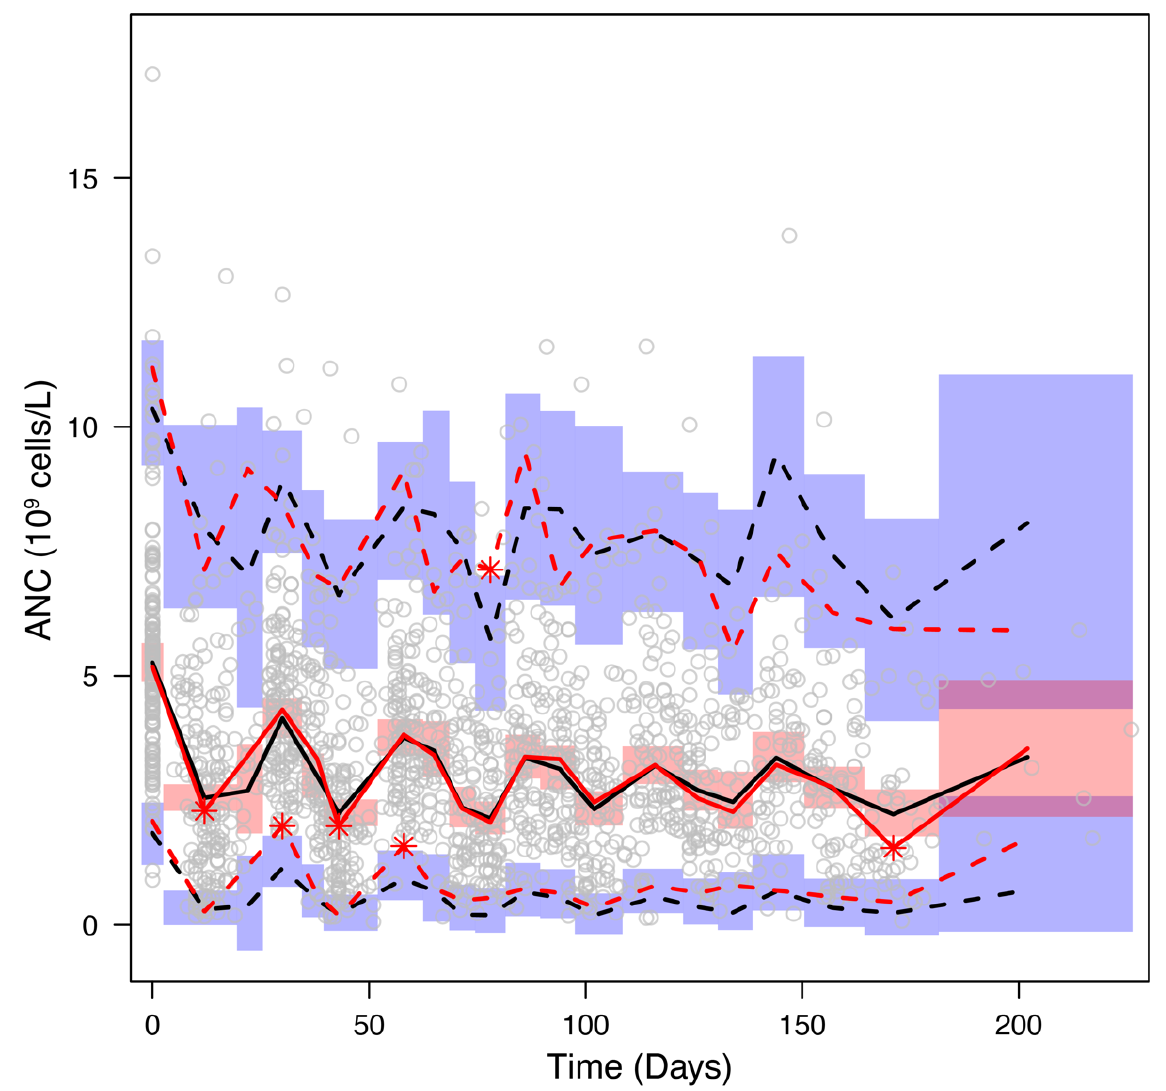
Figure 3. Visual predictive check plot. Open circles represent ANC observations. Red solid and dashed lines represent the median and 5%/95% observed data values, respectively. Black solid and dashed lines represent the median and 5%/95% simulated data values, respectively. Red areas indicate the 95% confidence intervals on the simulated median. Blue areas indicate the 95% confidence intervals on the simulated 5% and 95% values.